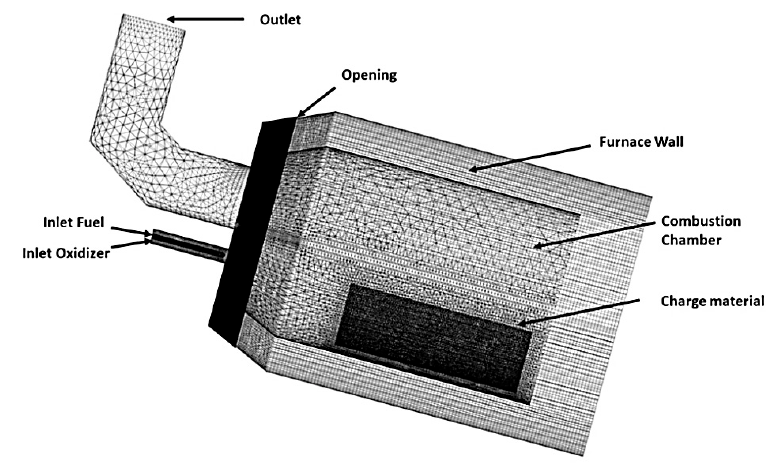
Figure 11. CFD model of laboratory-scale model. Figure 11 CFD model of laboratory-scale model.